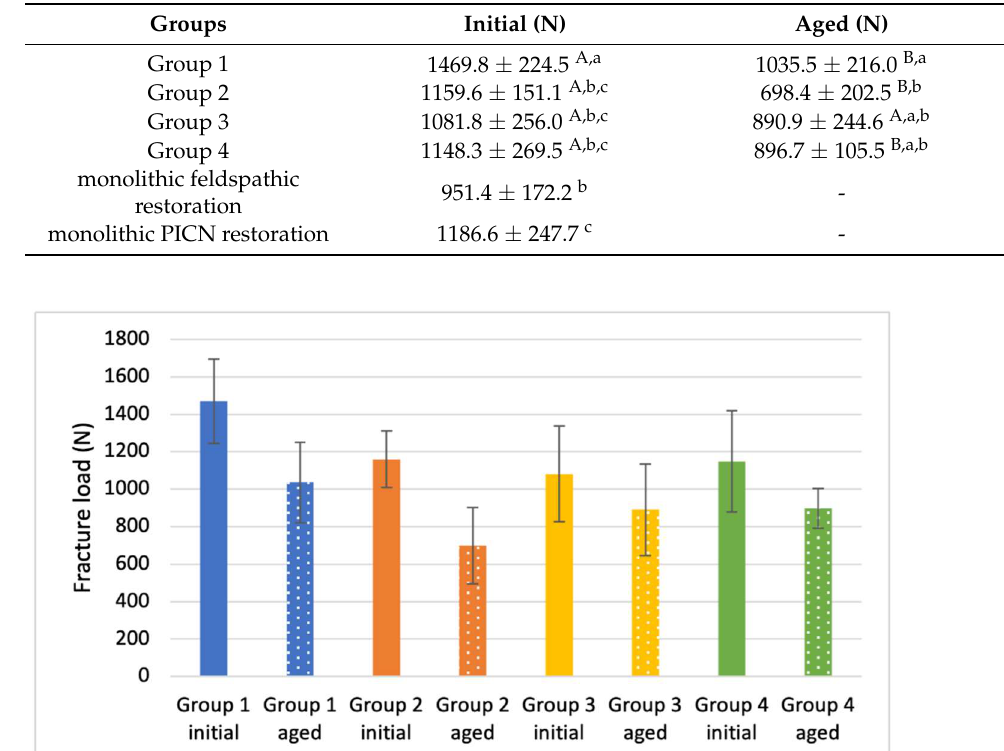
Table 3. Fracture load means and standard deviations. Statistically significant differences between groups determined with Fisher-LSD post-hoc test are indicated with varying superscript letters ( p > 0.05) (upper case horizontal, lower case vertical).